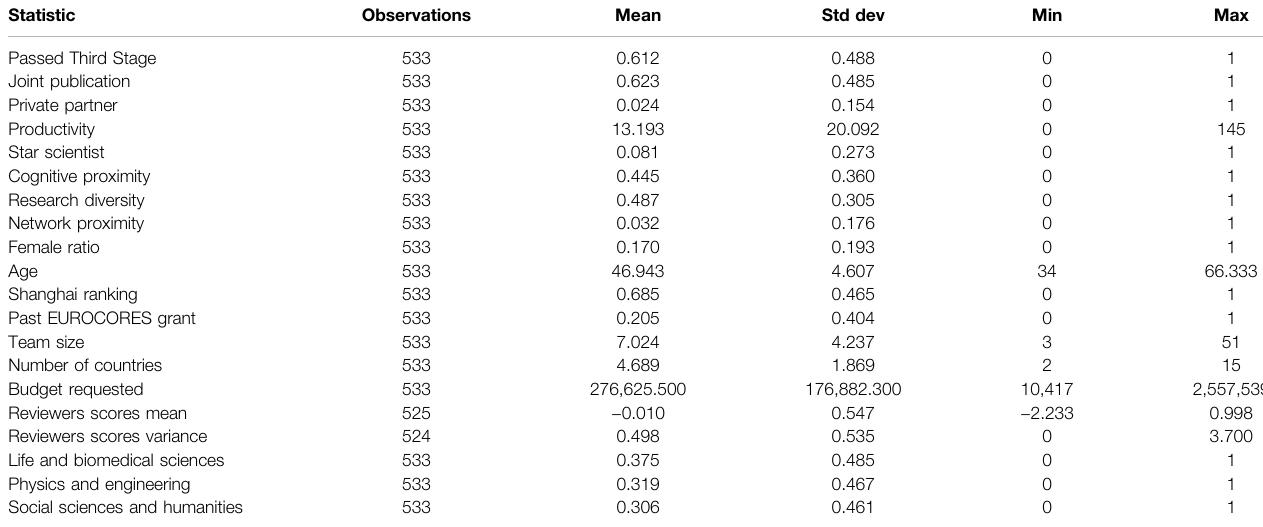
TABLE 4 | Descriptive statistics of applicants — Third Stage. Statistic